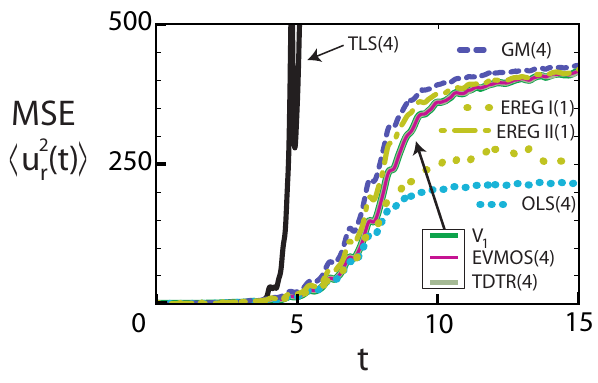
Fig. 4. The short-time mean square error (MSE) evolution for the Lorenz model with large model error ( δr = 10 − 2 ) and with 5 × 10 5 ensembles of 500 members. The lines indicated with “1 predictor” and “4 predictors” apply to all regression methods except for GM and EREG II.